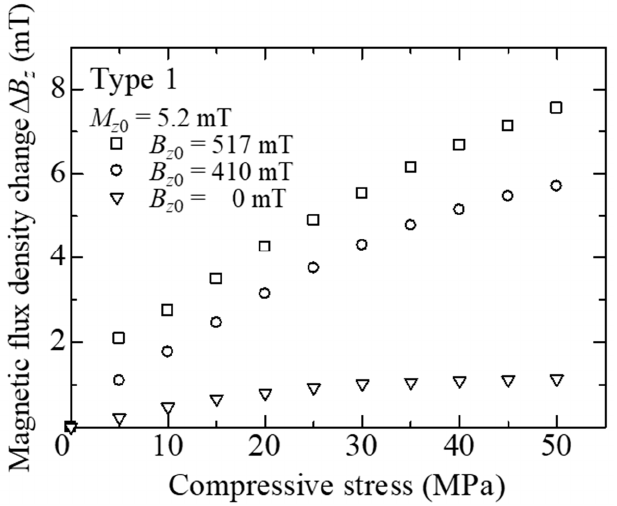
Figure 7. Magnetic flux density change ∆ B z versus compressive stress of the Type 1 sample under various bias magnetic fields Bz 0 .